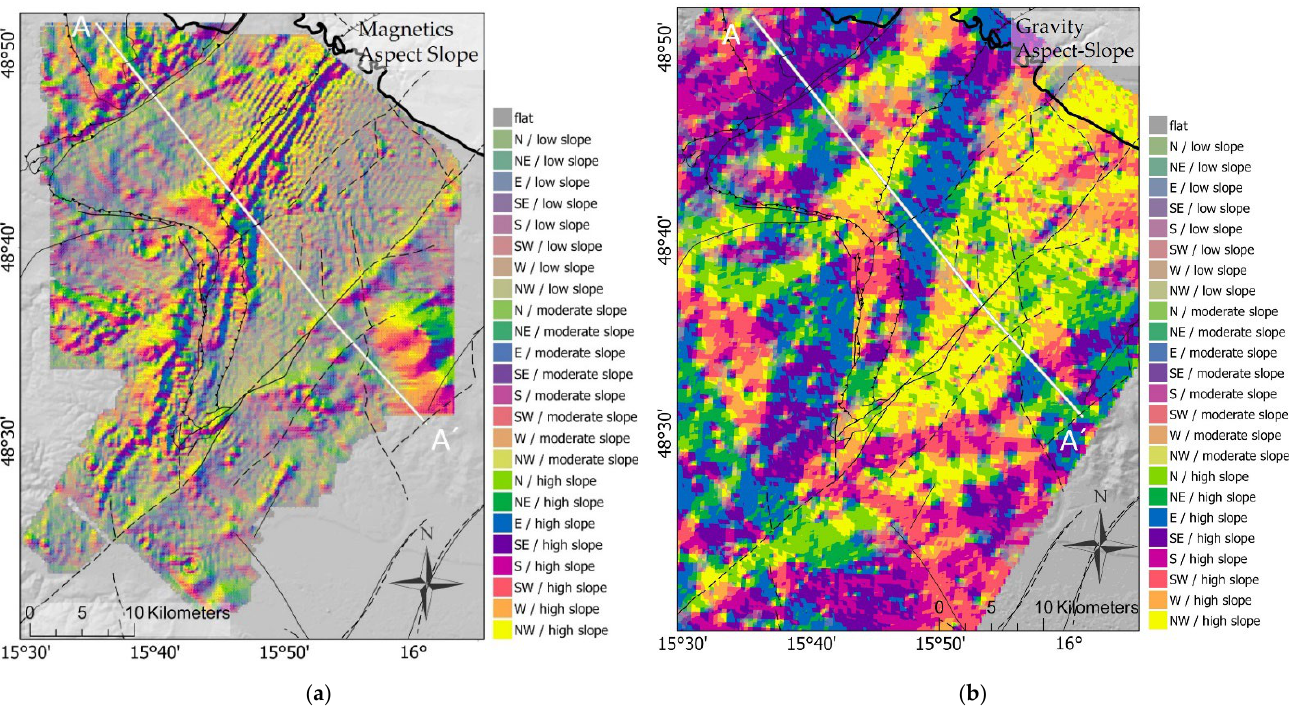
Figure 8. ( a ) Aspect—slope applied to the magnetic total intensity with z-factor 10 and ( b ) to the Bouguer gravity anomaly. Color saturation represents the steepness and hue (color) represents the direction of the aspect. Background map: Lidar image with a 10 × 10 m resolution.